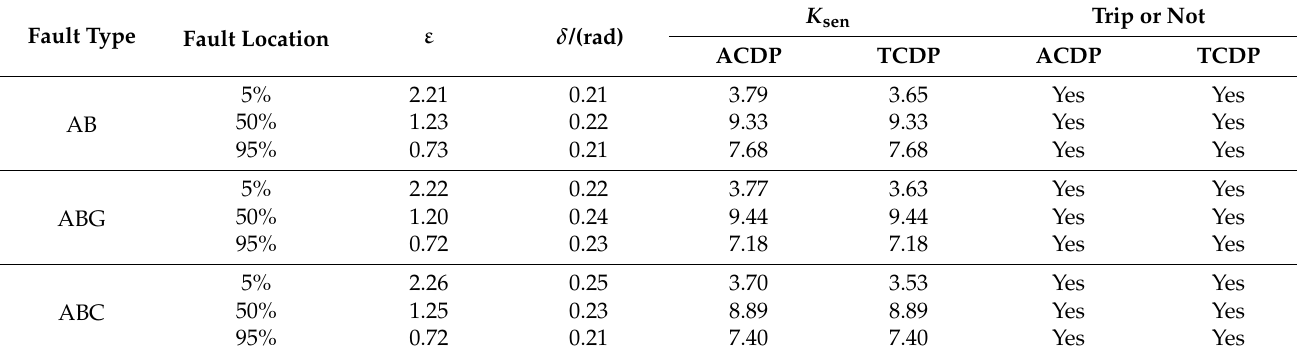
Table 4. Simulation results of metallic multi-phase faults at feeder B 7 B 8